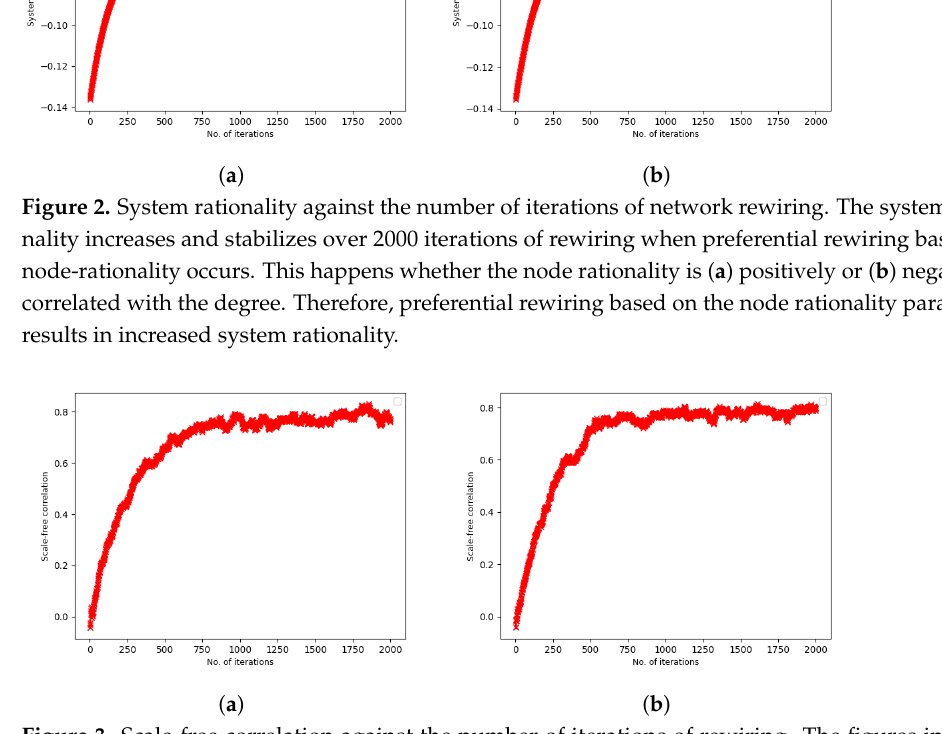
Figure 3. Scale-free correlation against the number of iterations of rewiring. The figures indicate that the scale-freeness of the topology increases over 2000 iterations of rewiring when preferential re-wiring based on node-rationality occurs. This happens whether the node rationality is ( a ) positively or ( b ) negatively correlated with the degree. Therefore, preferential rewiring based on the node rationality parameter results in increased